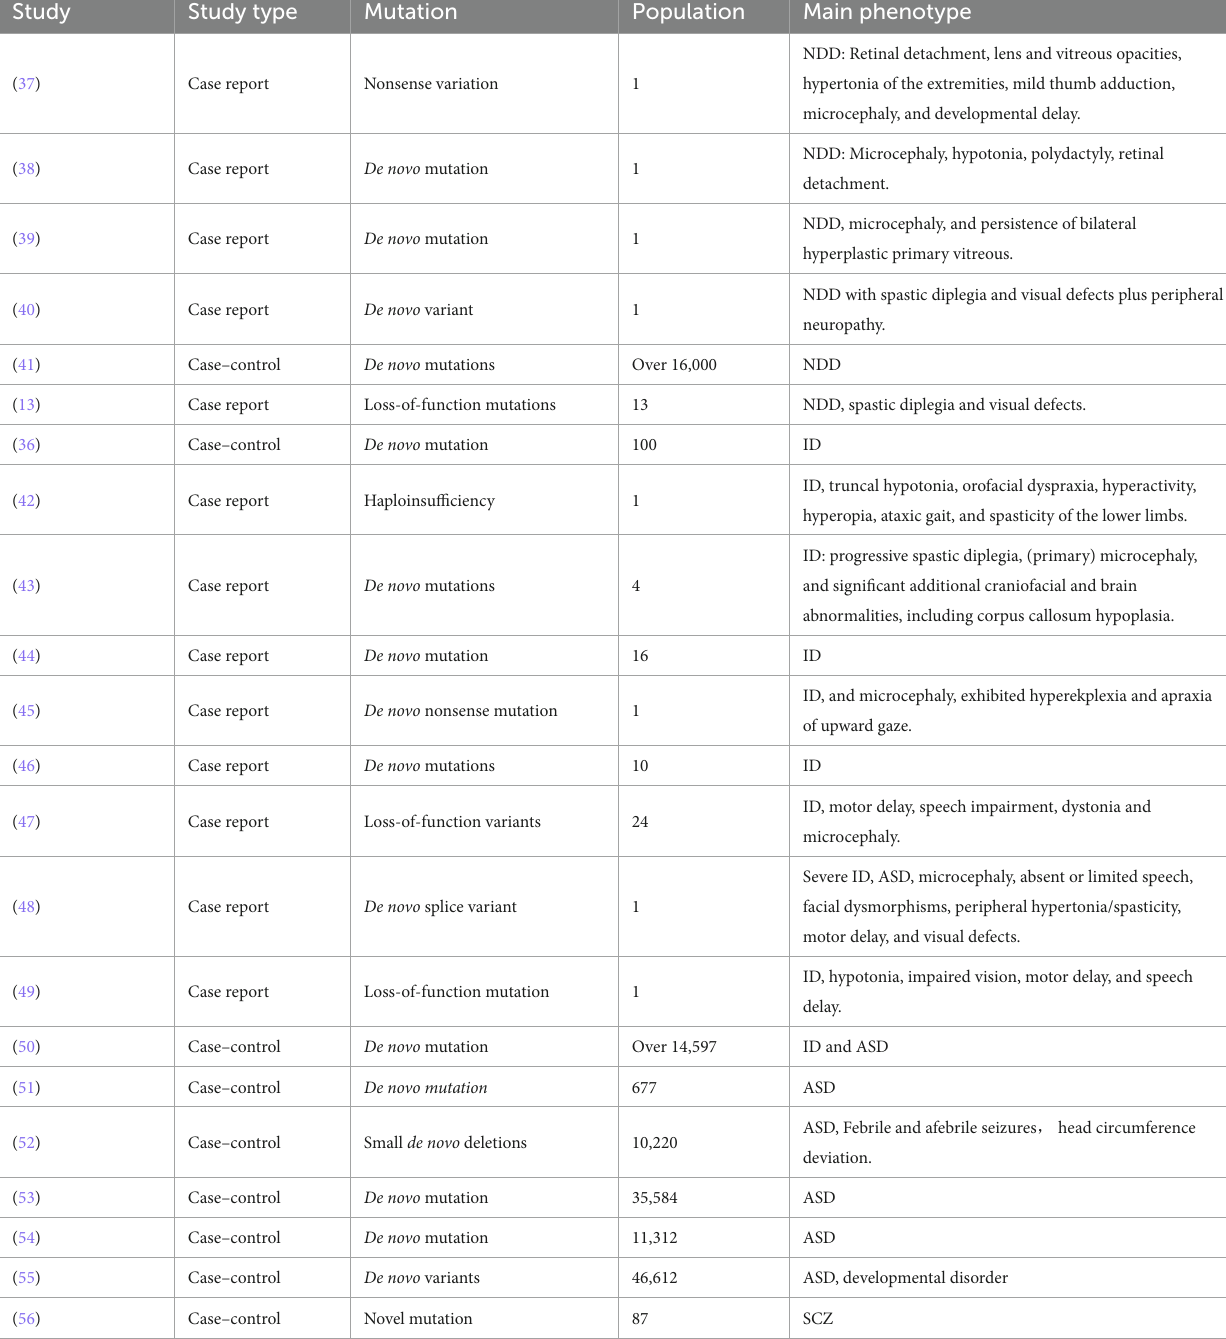
TABLE 1 Summary of recent CTNNB1-related NDDs in human studies. Study Study